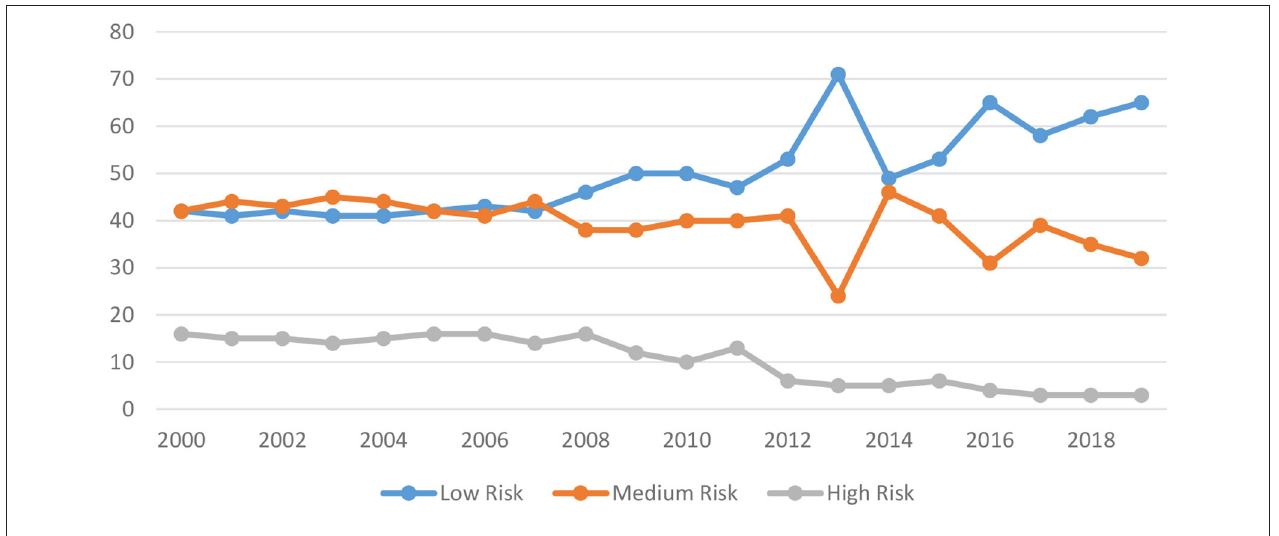
FIGURE 9 | Investment environment risk in Brazil from 2000 to